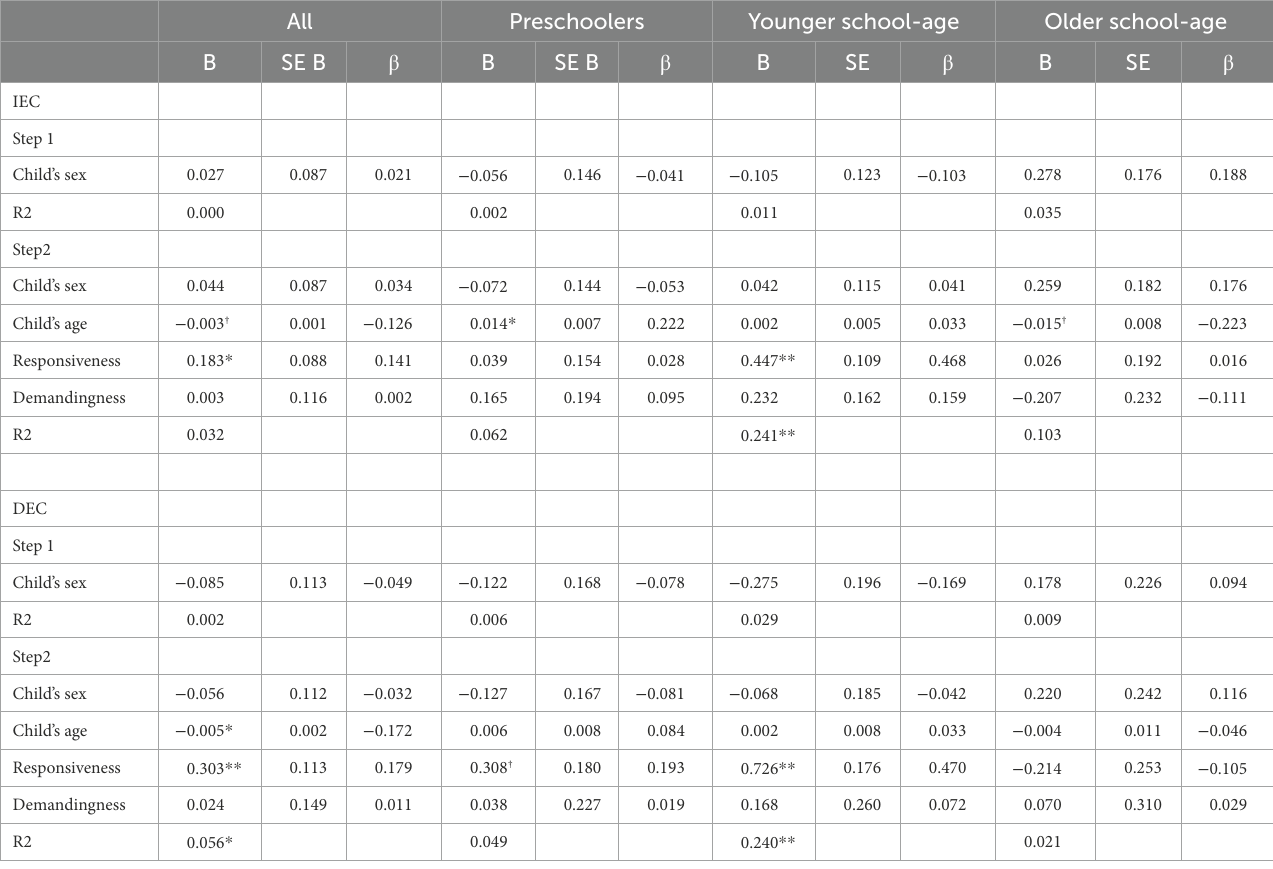
TABLE 3 Hierarchical regression analysis for variables predicting IEC and DEC